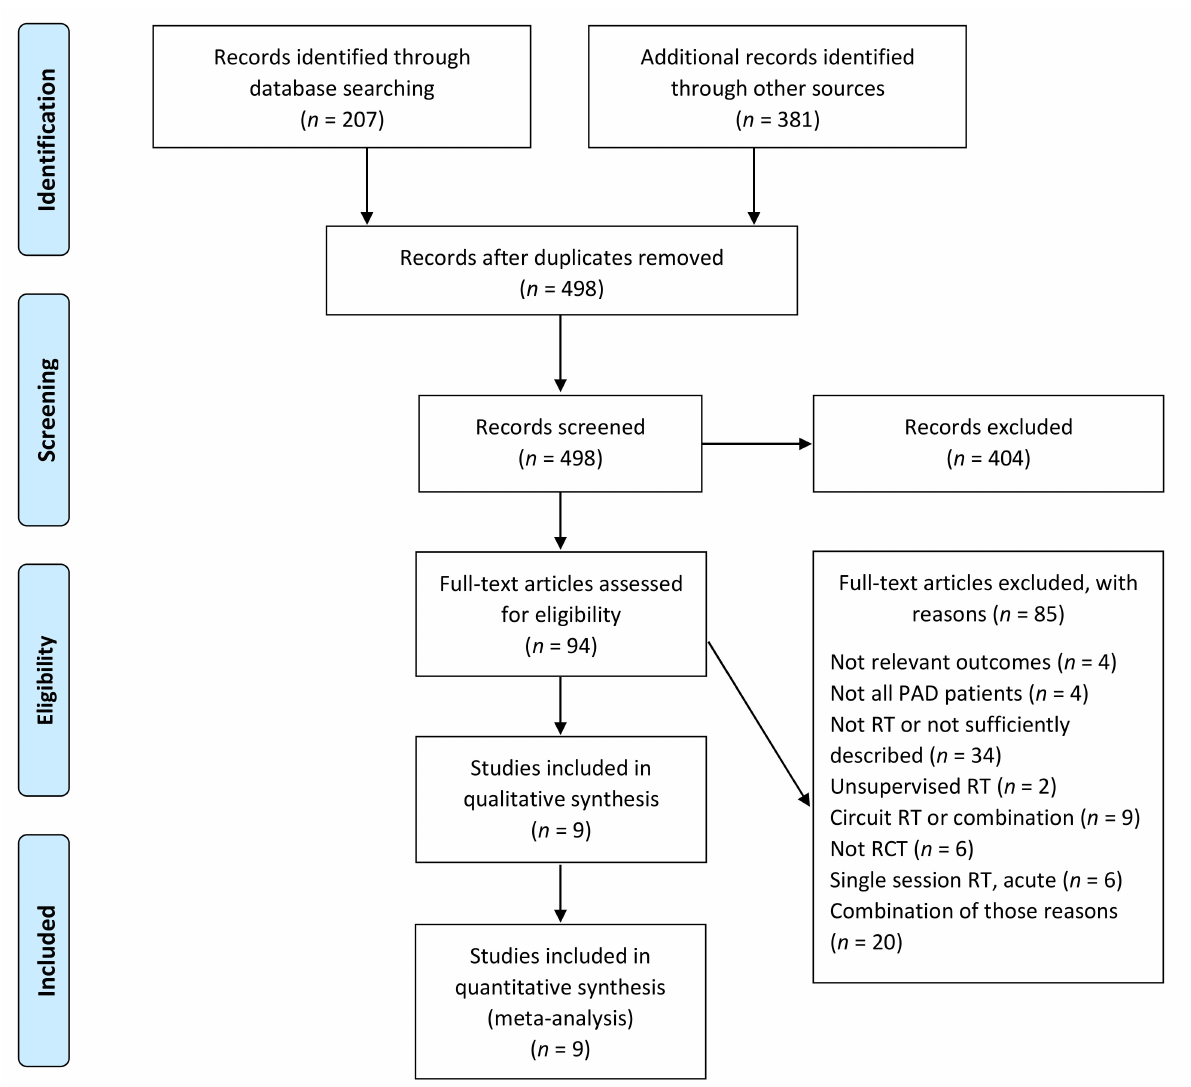
Figure 1. PRISMA flow diagram of the study selection process. PRISMA, Preferred Reporting Items for Systematic Reviews and Meta-Analyses; PAD, peripheral artery disease; RT, resistance training; RCT, randomized controlled